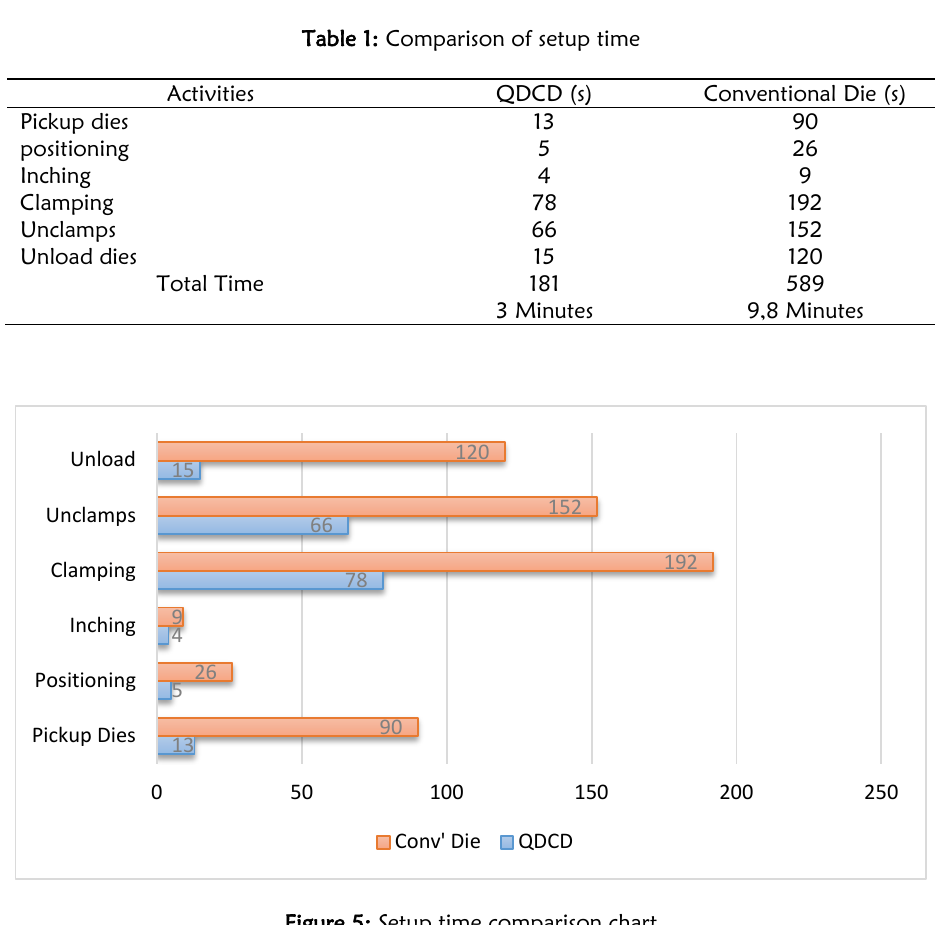
Figure 5: Setup time comparison chart